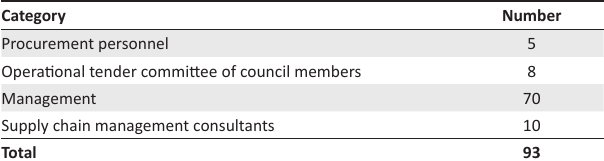
TABLE 1: Profile of target population. Category Number Procurement